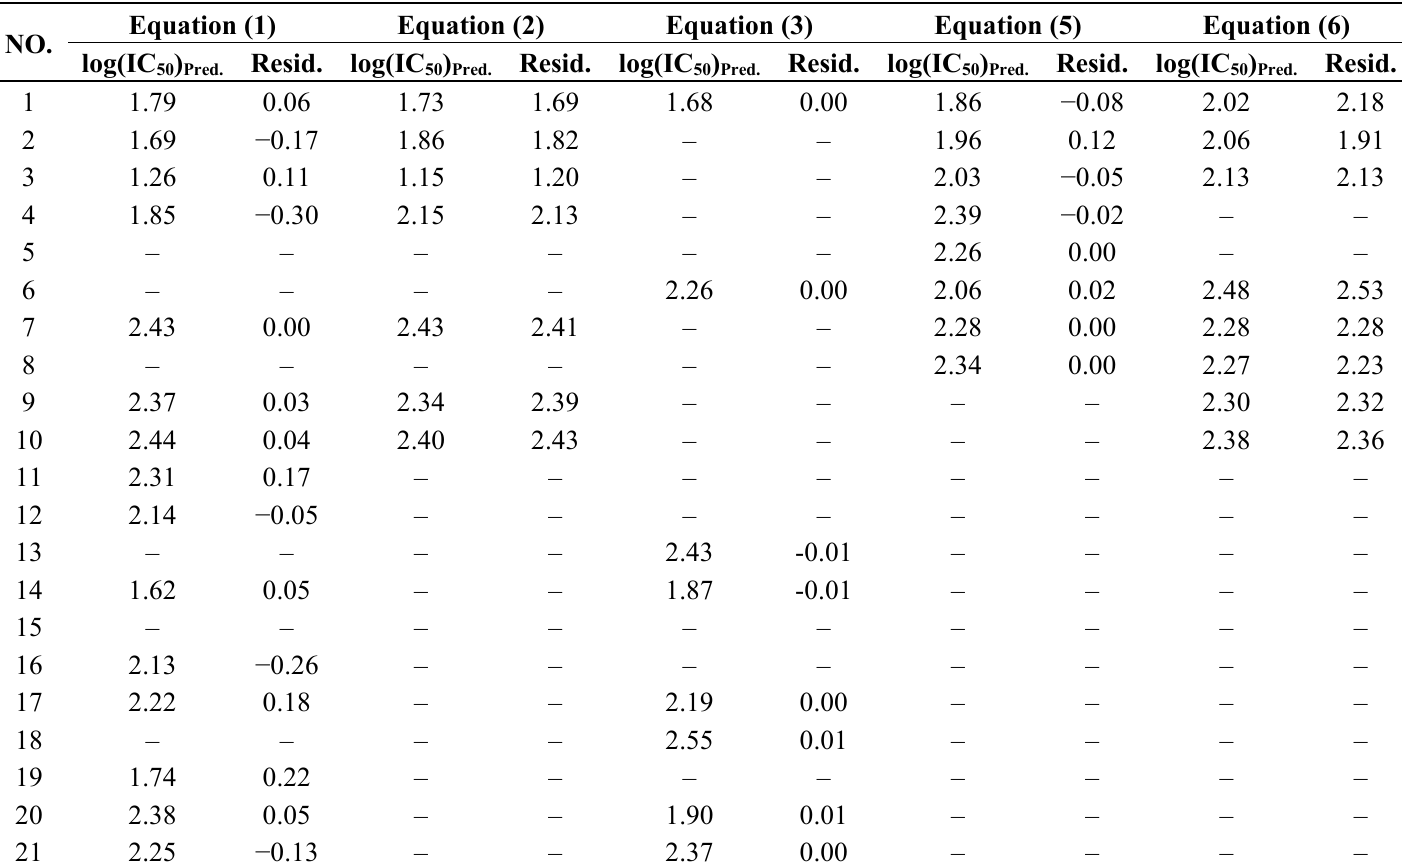
Table 3. Predicted log(IC 50 ) Pred . and residuals of the active compounds obtained using MLR Equations (1)–(6). Equation (1) Equation (2) Equation (3) Equation (5) Equation (6) NO. log(IC 50 ) Pred. Resid. log(IC 50 ) Pred. Resid. log(IC 50 ) Pred. Resid. log(IC 50 ) Pred. Resid. log(IC 50 )